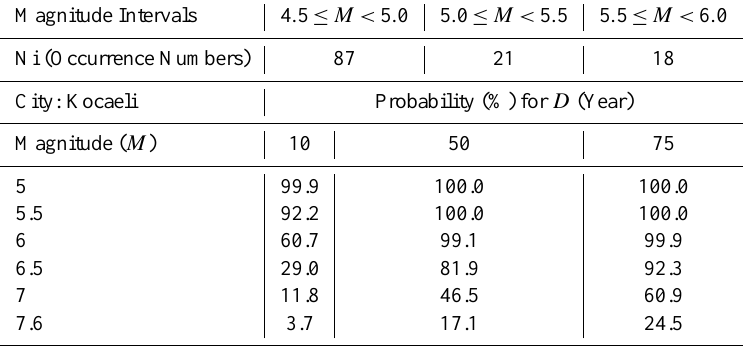
Table 3p. Earthquake occurrence probability (%) for D (Year) for Kocaeli city. Magnitude Intervals